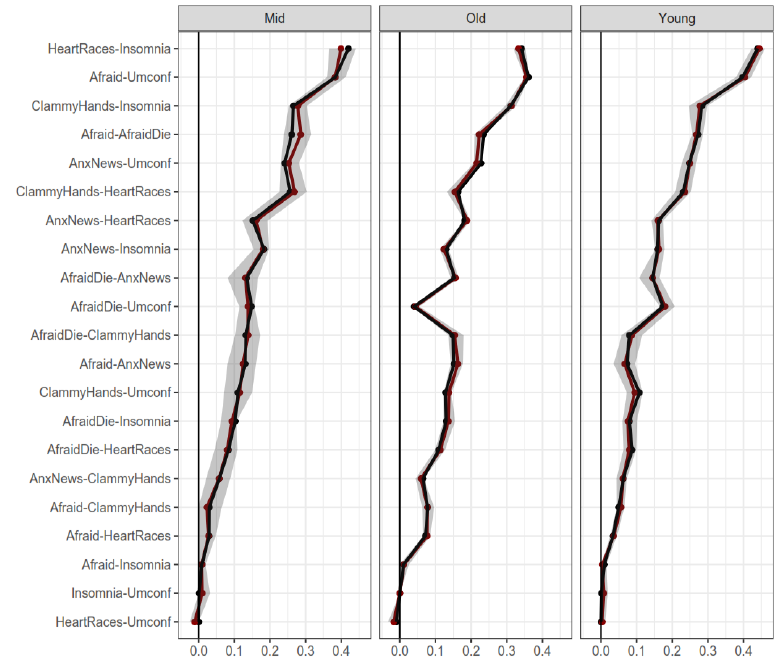
Figure 5. Bootstrapped edges for networks of the young age (18–29 years old), middle age (30–49 years old), and old age (>50 years old). Note: Horizontal axis represent edge weight. Shaded regions represent 95% confidence intervals for the measures.